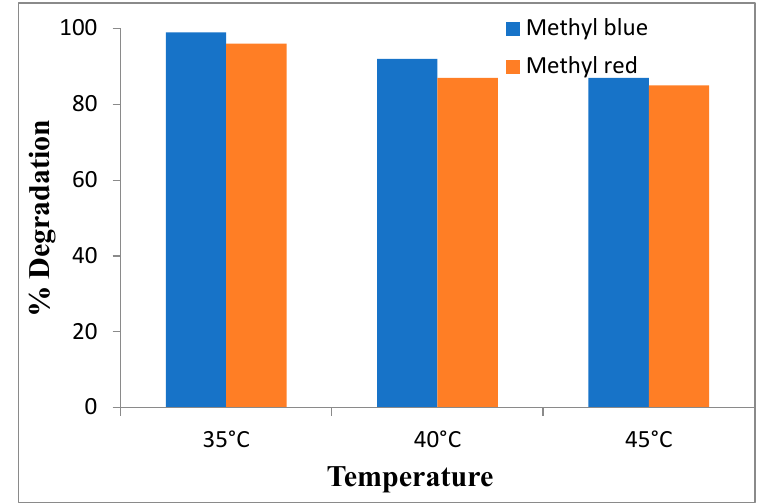
Figure 14. Influence of temperature on the degradation efficiency of the dyes.